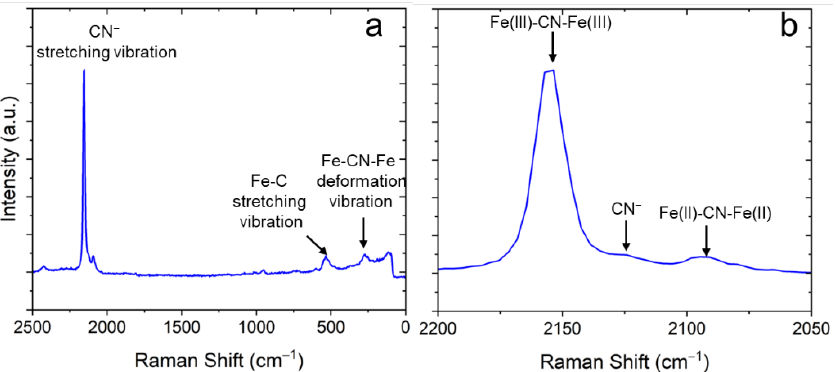
Figure 6. Typical Raman spectrum of electrodeposited NaFeHCF layers measured with 532 nm laser at 1 mW: ( a ) overview, ( b ) detailed view of the spectral region around the CN-stretching vibration.